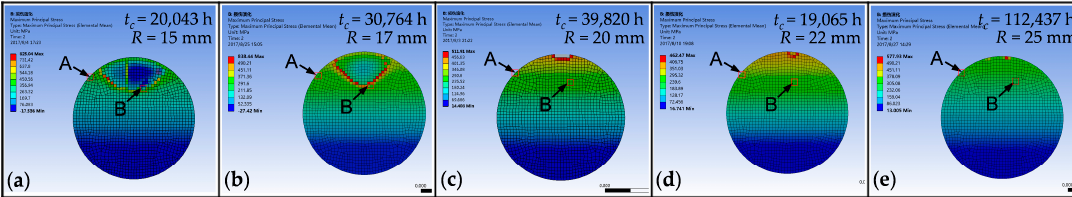
Figure 5. The fracture surface morphologies for different bending radii at 29,411 h and positions of selected elements. ( a ) t c = 20,043 h, R = 15 mm; ( b ) t c = 30,764 h, R = 17 mm; ( c ) t c = 39,820 h, R = 20 mm; ( d ) t c = 19,065 h, R = 22 mm; ( e ) t c = 11,2437 h, R = 25